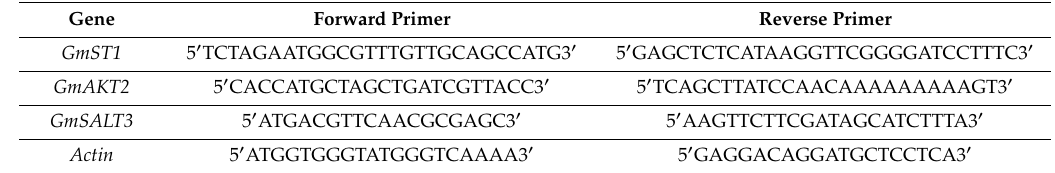
Table 1. Primers used for relative gene expression